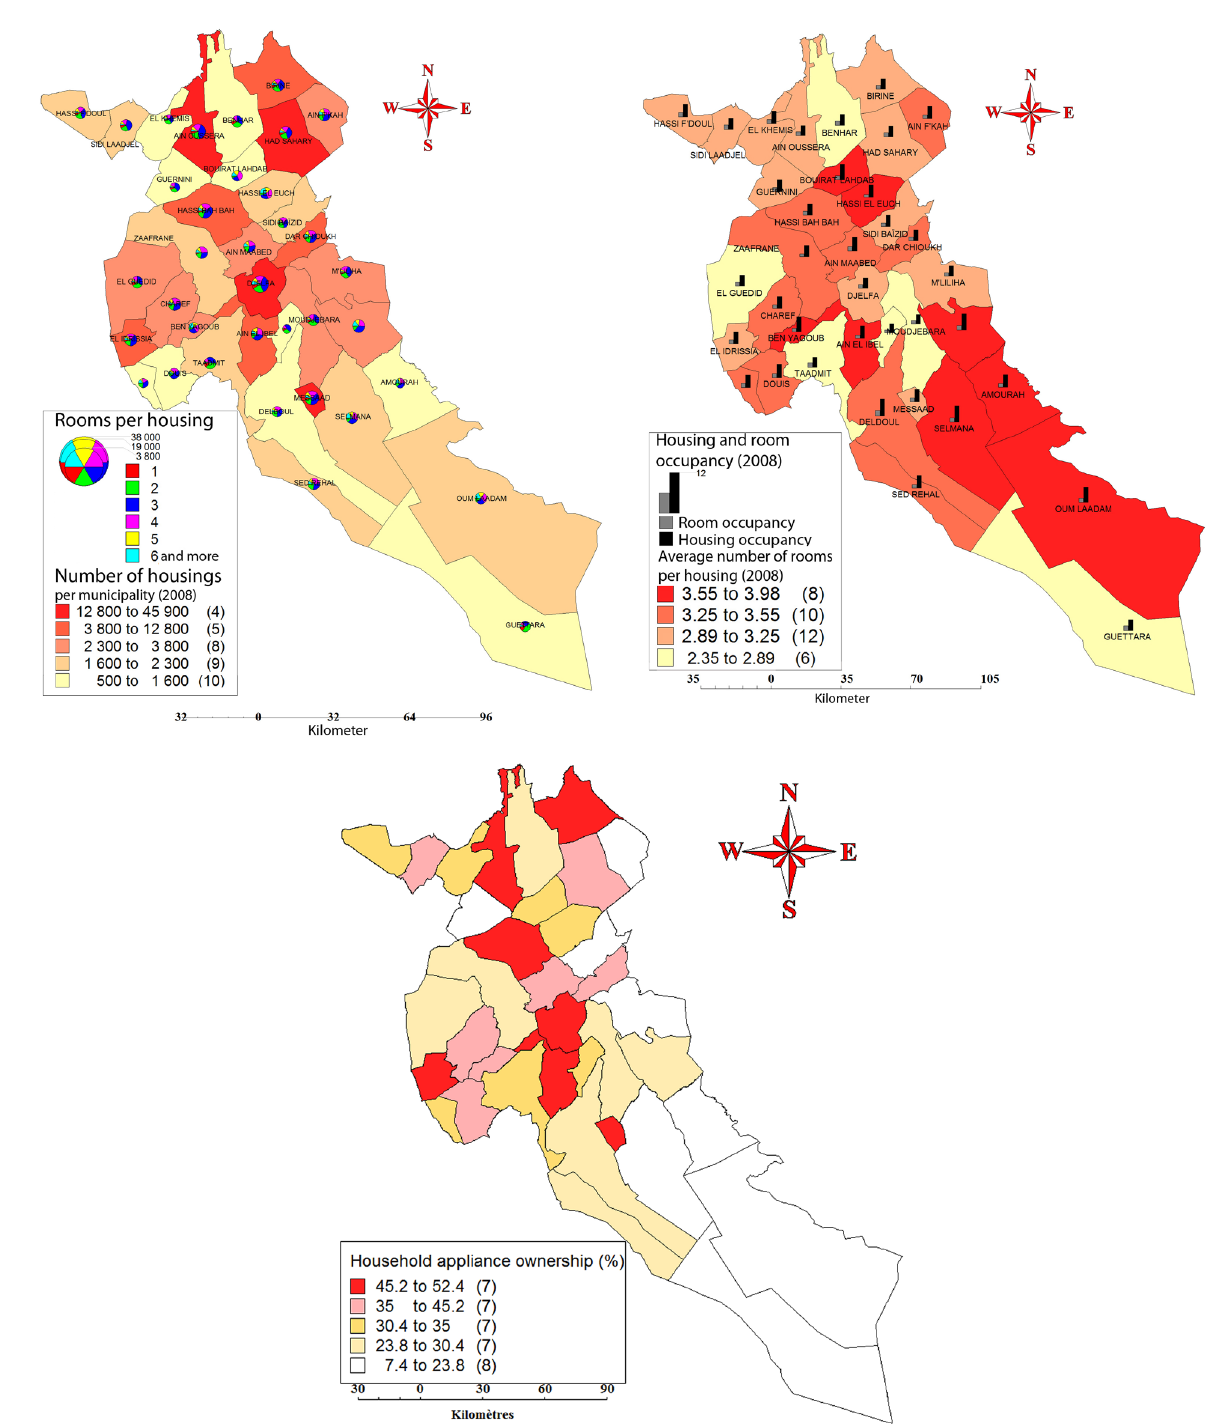
fig. 5. (a) housing number and size, (b) household size, room occupancy and average number of rooms per housing, (c) appliance ownership (TV, cooker, washing machine, refrigerator and air